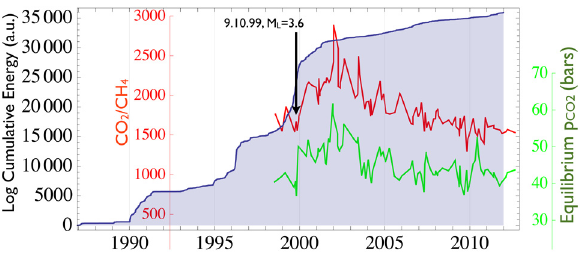
Figure 6. Cumulative seismic energy (blu line), ratio between car- bon dioxide and methane (red line) and P line) since